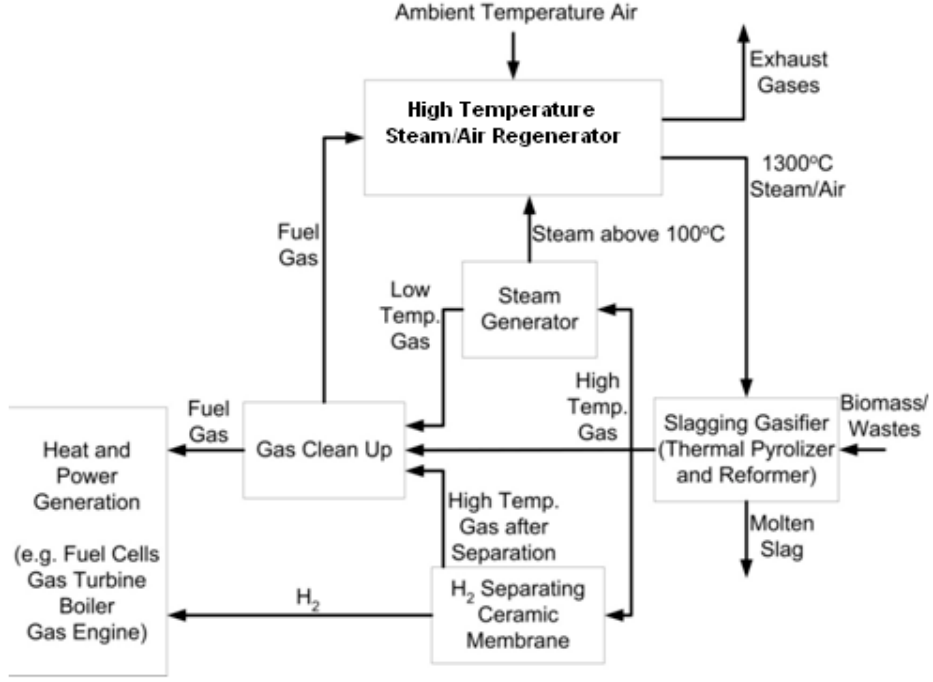
Figure 1. Schematic layout of an advanced temperature air and air/steam (HiTAG/HiTSG) system in view of fuel gas or hydrogen-rich gas production.